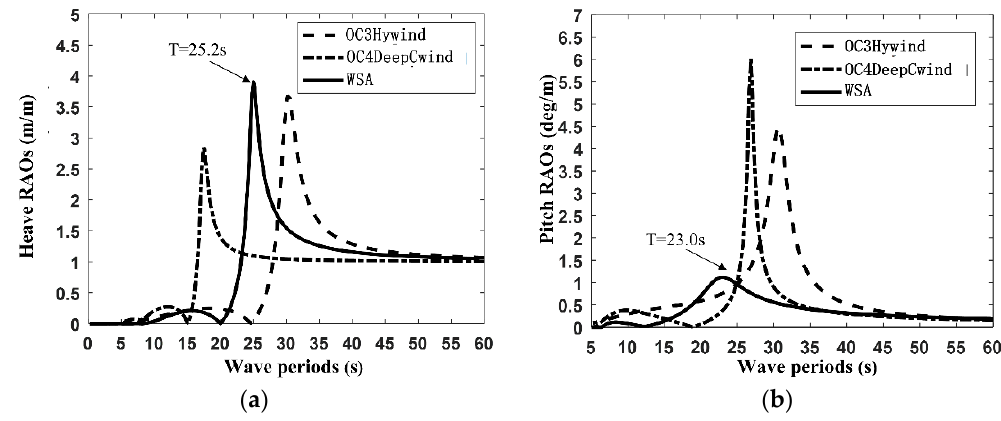
Figure 12. Comparisons of motion response amplitude operators (RAOs) in freely floating states. ( a ) Heave; ( b ) Pitch. Table 5. Natural periods and equivalent damping ratios of the WSA rigid body motions. Motion Natural Period